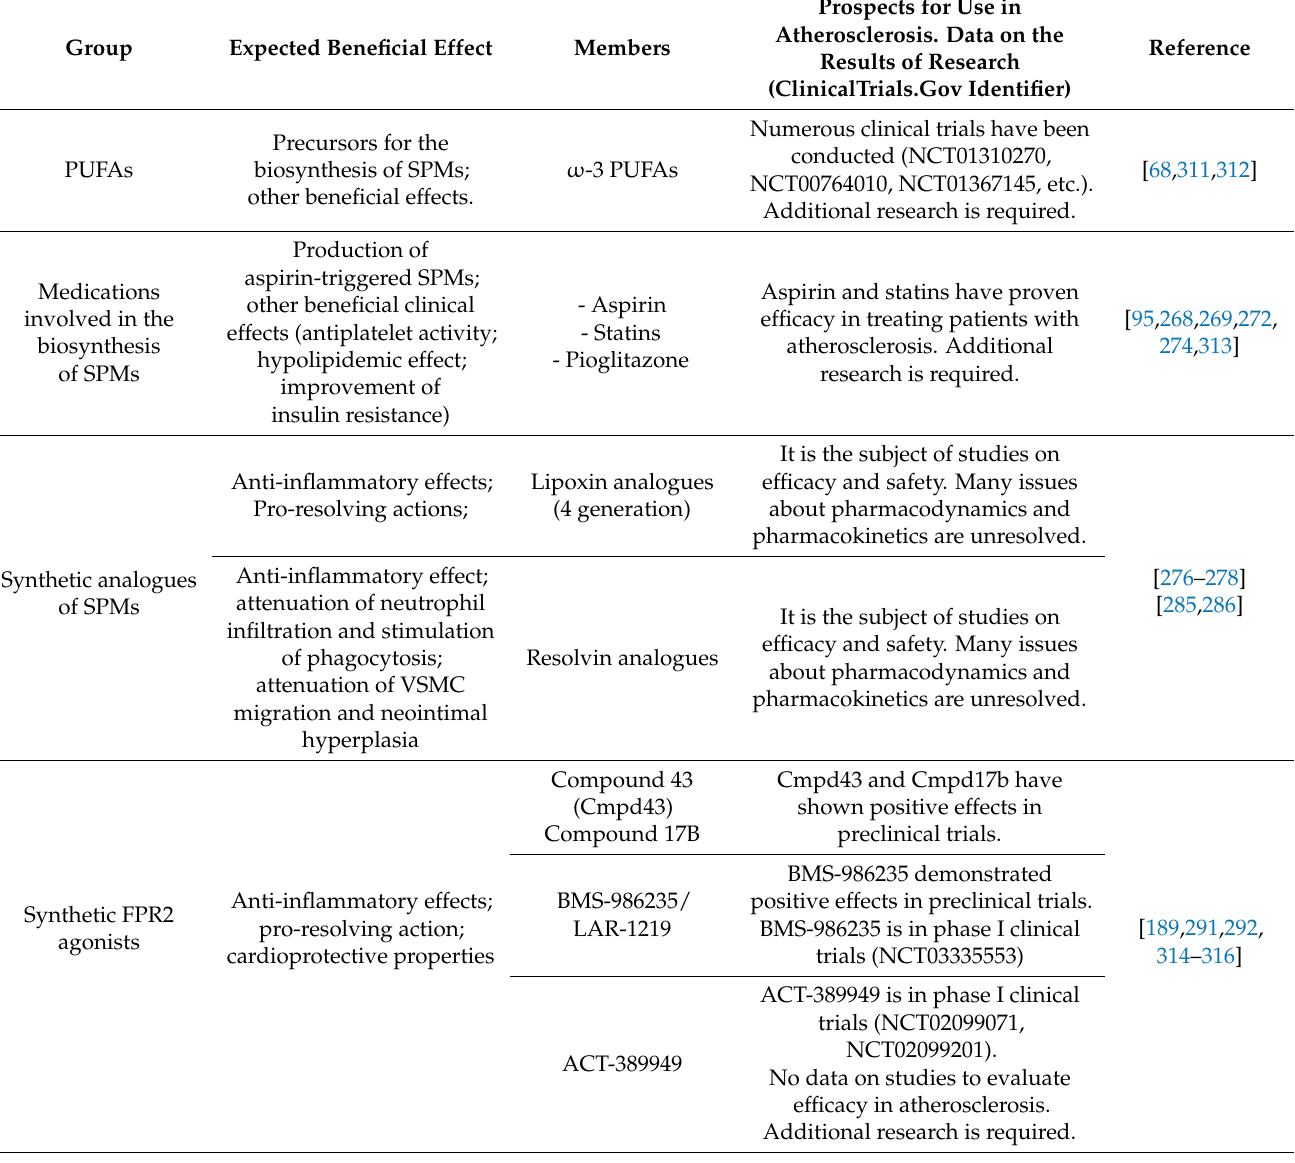
Table 1. Clinical perspectives on the regulation of inflammation